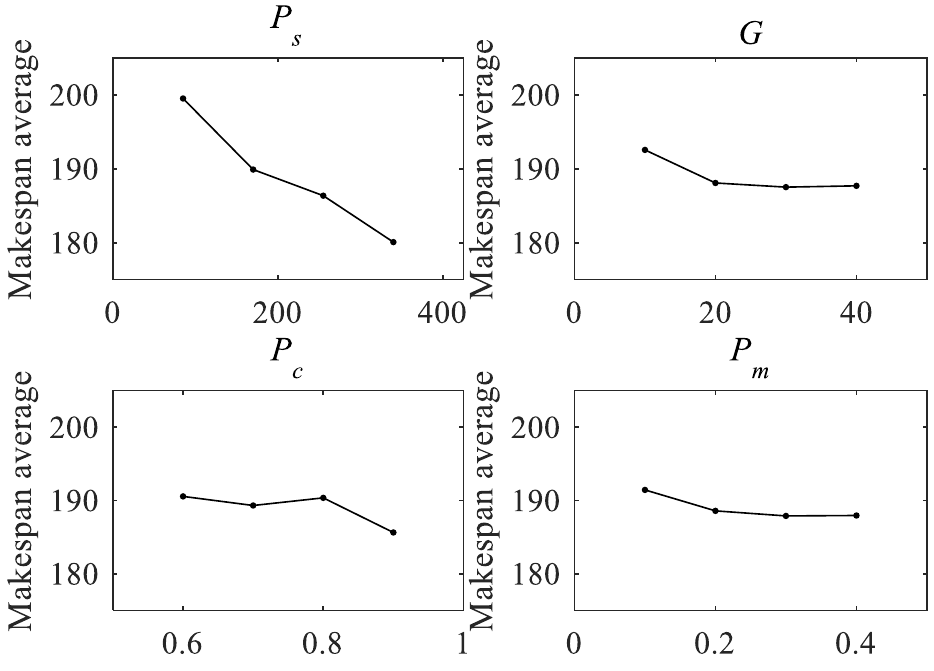
Figure 11. The trend of algorithm results under different parameters.